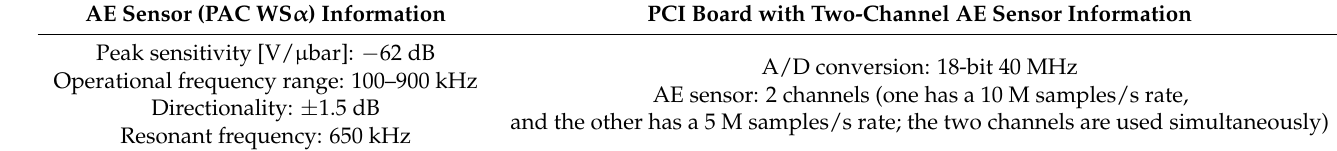
Table 1. Sensor and data collection system information [9].